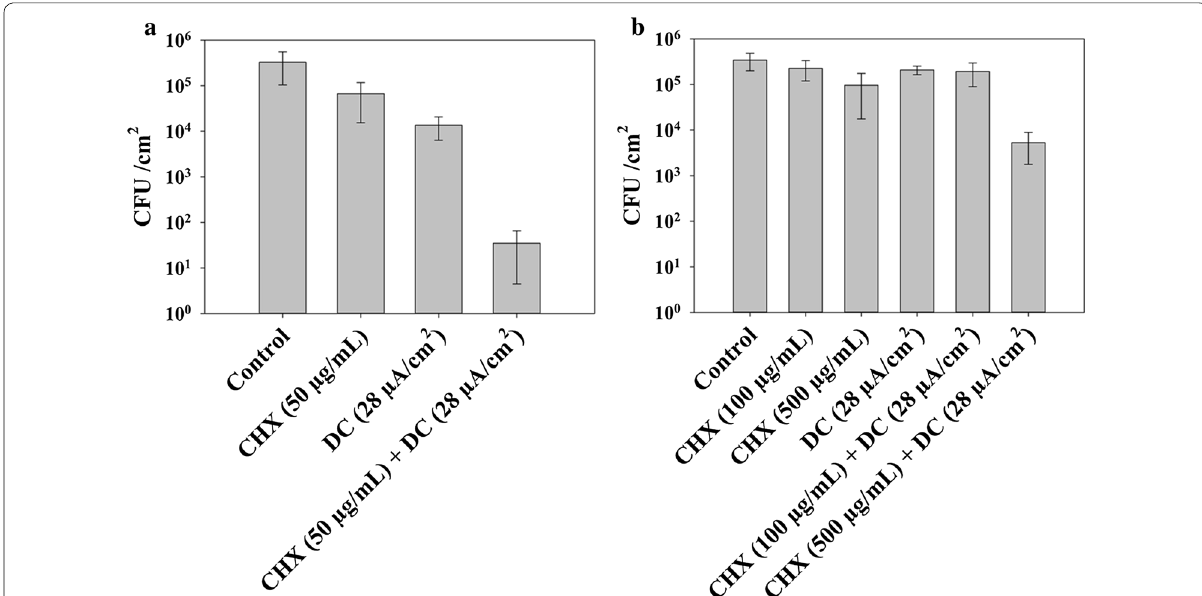
Fig. 2 Viability of S. mutans biofilm cells after treatment with CHX, DC, or concurrent treatment. a Treatment in 0.85% NaCl. DC level: 28 µA/cm 2. CHX dosage: 50 µg/mL. b Treatment in artificial saliva. DC level: 28 µA/cm 2 . CHX dosage: 100 or 500